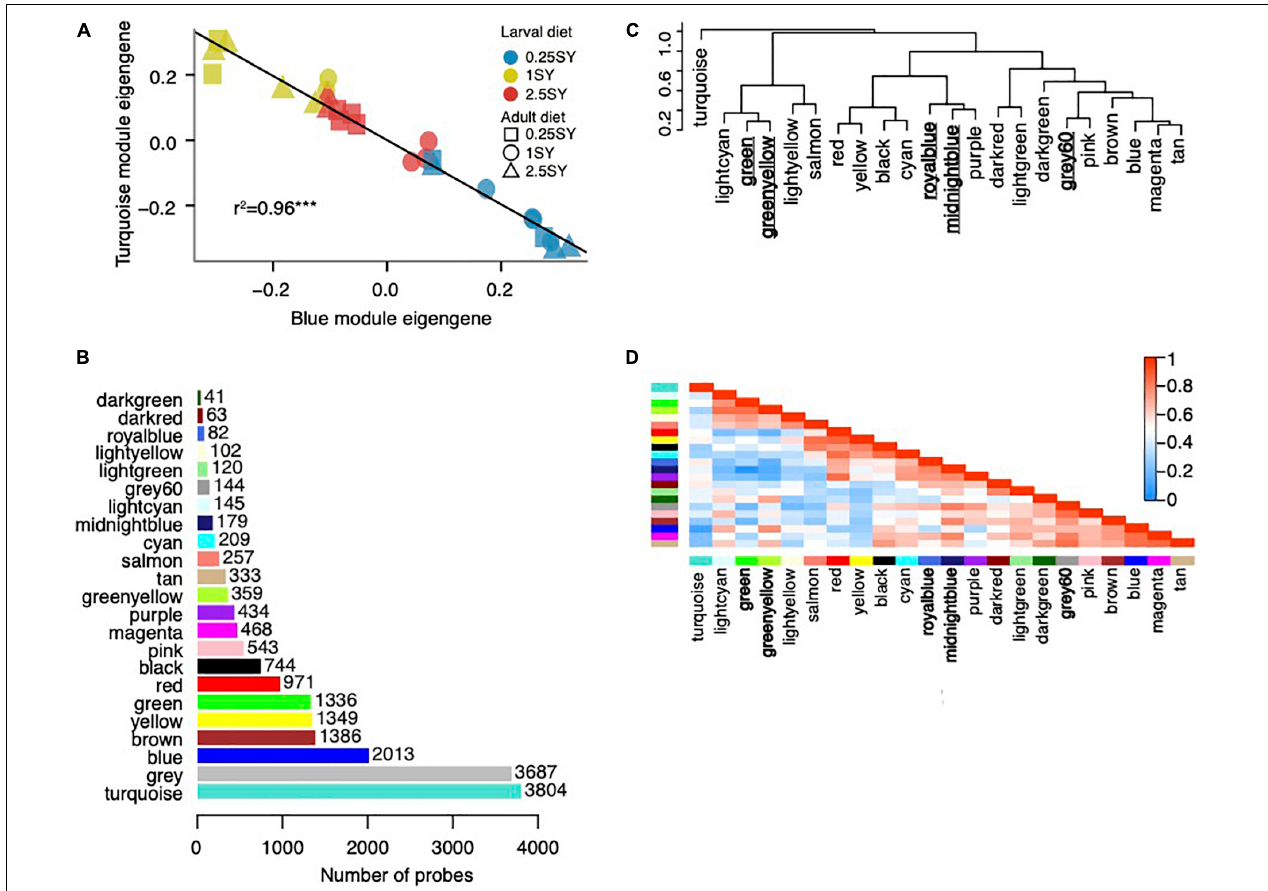
FIGURE 2 | Modules detected by WGCNA. (A) Module eigengenes of the female blue module plotted against eigengenes of the female turquoise module. Eigengenes of the two modules are nearly perfectly negatively correlated ( r 2 = 0.96). (B) Module sizes in males. (C) Hierarchical clustering dendrogram of male module eigengenes (labeled by their colors). (D) Heatmap plot of the adjacencies in the eigengene network. Each row and column in the heatmap corresponds to one module eigengene (labeled by color). A value of 1 (red) represents high adjacency (perfect positive correlation), while 0 (blue) represents low adjacency (perfect negative correlation). Modules with high adjacency tend to have similar tissue-specific expression profiles in the FlyAtlas and FlyGut datasets. For both sexes, the “gray” module contains probes that were unassigned to a